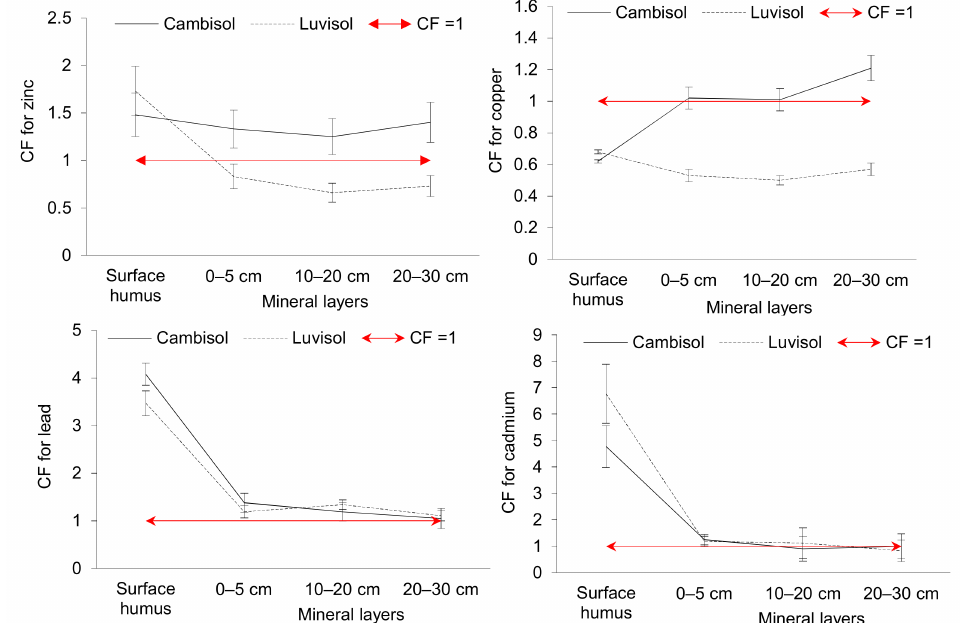
Figure 3. Soil contamination factors (arithmetic mean ± standard deviation) of trace elements (CF < 1 = low contamination; 1 ≤ CF < 3 = moderate contamination; 3 ≤ CF < 6 = considerable contamination; CF > 6 = very high